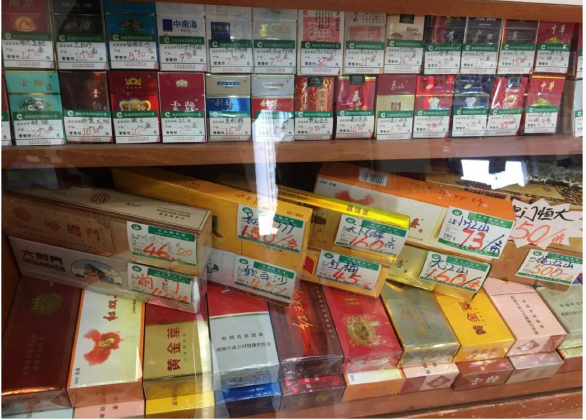
Figure 1. Display of cigarettes in a supermarket Tianjin, China on 17 January